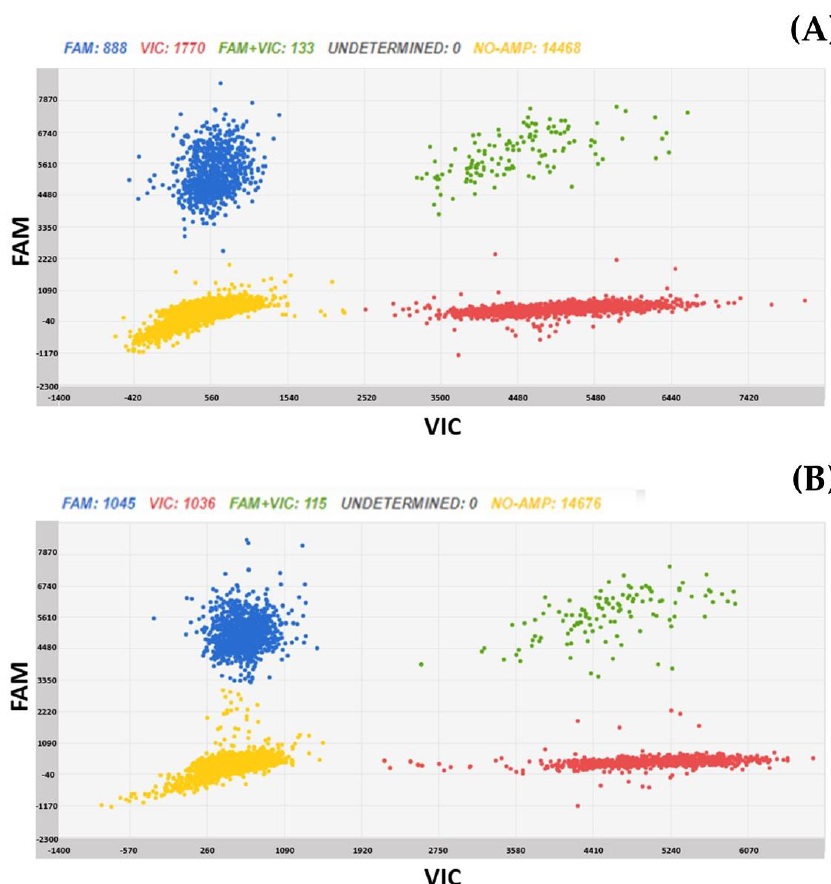
Figure 6. Chip digital PCR scatter plots of Solina 1 ( A ) and of Solina 2 ( B ) samples, carrying, respectively two and one copy of vrn-A1 gene. Blue dots are chip wells in which Pinb-D1 gene (marked with FAM) has been amplified, red dots are wells in which vrn-A1 gene (marked with VIC) has been amplified, green dots are wells in which both genes have been amplified, whereas yellow dots are wells without any amplification. From raw data, the software calculates the number of copies/µL of each gene. The ratio between vrn-A1 copies and Pinb-D1 copies is 1.9 for Solina 1 and 1 for Solina 2.